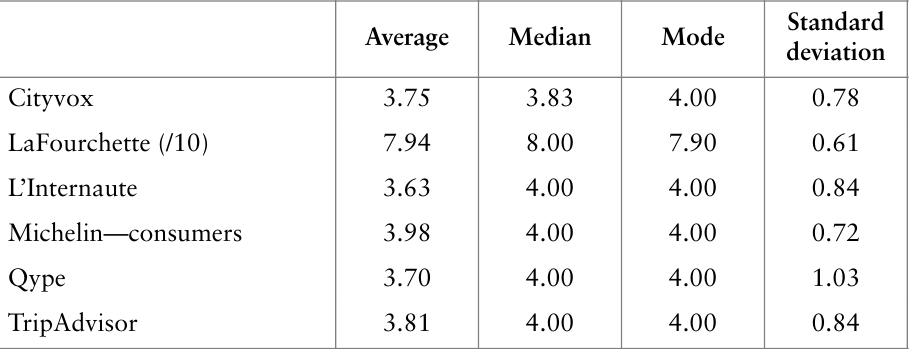
Table 10. Average and median rating of restaurants.